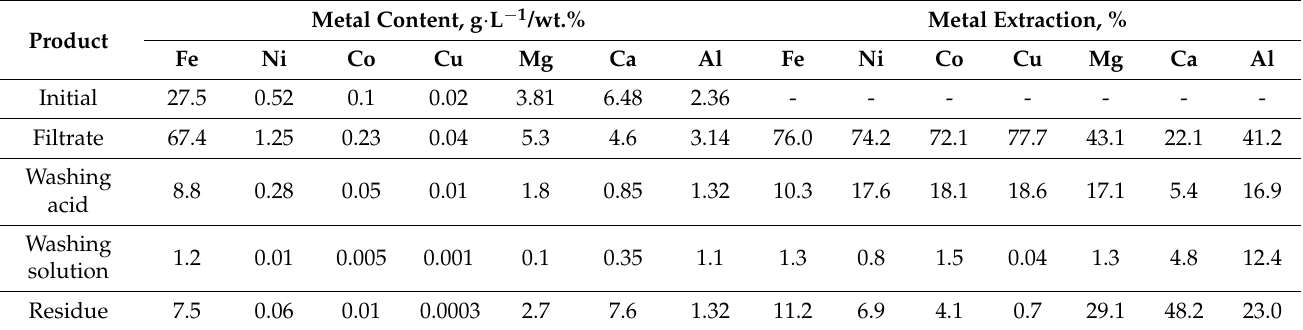
Table 5. Valuable component distribution in slag leaching with hydrochloric acid washing solution